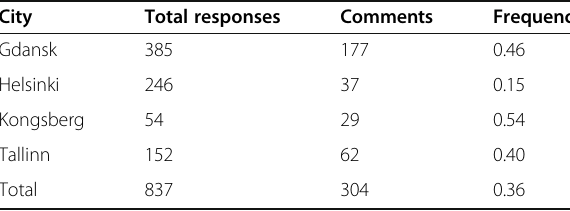
Table 6 Frequency of free comments per total responses for each